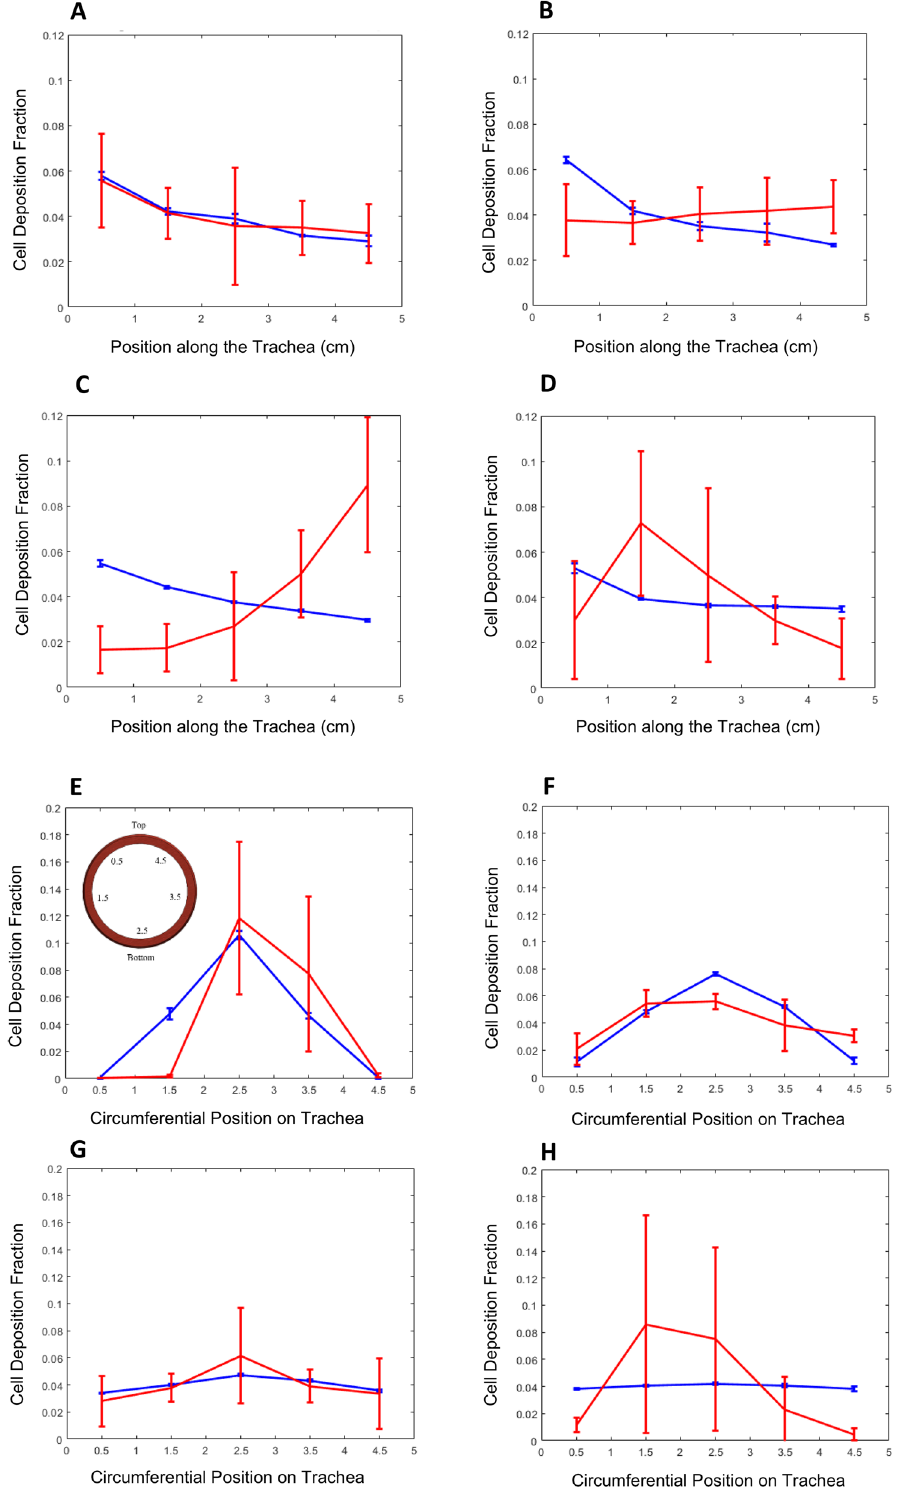
Figure 4. Averaged cell deposition density fraction plots along tracheal length and circumferential position. Simulation (blue) and experimental (red) results at 0 rpm ( A , E ), 1 rpm ( B , F ), 5 rpm ( C , G ), and 15 rpm ( D , H ), single rotating inlet